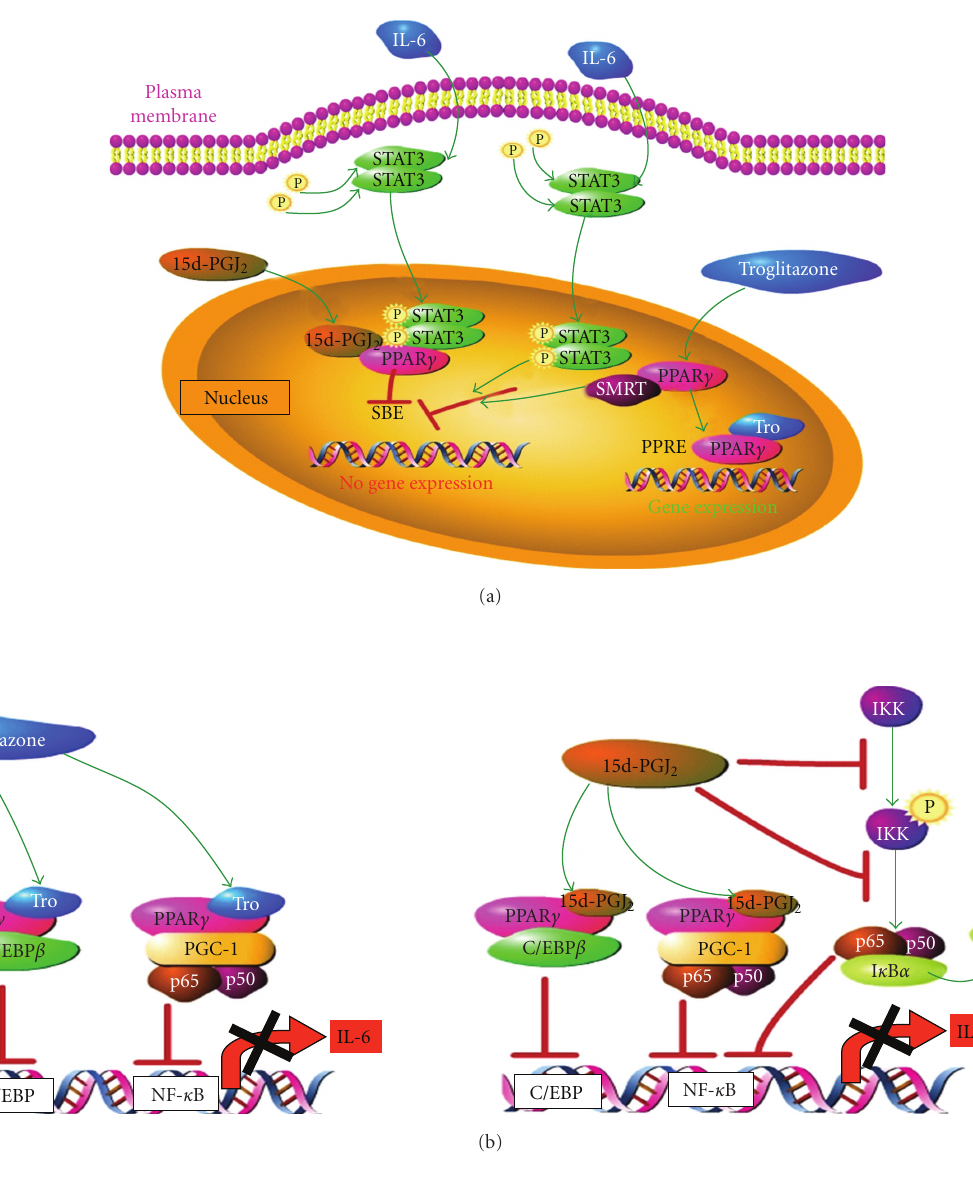
Figure 3: PPAR γ agonists inhibit Stat3-mediated IL-6 gene expression in myeloma cells. Inactivation of IL-6-activated Stat3 by PPAR γ agonists occurs in a PPAR γ -dependent manner; however, the molecular mechanisms by which two distinct PPAR γ agonists (15d-PGJ 2 and troglitazone) suppress IL-6-activated Stat3 in MM cells di ff er as shown in (a) [211]. Direct complex formation between phosphorylated Stat3 and PPAR γ activated by 15d-PGJ 2 prevents Stat3 binding to its cognate response element (SBE) on the promoters of target genes ((a), left). This mode of transcriptional inactivation does not require binding of the activated PPAR γ transcription factor to DNA in the promoter region and, thus, can occur in the absence of a PPRE. However troglitazone activated PPAR γ promotes redistribution of the corepressor SMRT from PPAR γ to phosphorylated Stat3 so that Stat3 can no longer recruit the transcriptional machinery necessary for gene expression ((a), right) [211]. High levels of IL-6 are found in MM and promote myeloma cell proliferation and survival and indirectly promote tumor- associated angiogenesis. The PPAR γ agonists troglitazone and 15d-PGJ 2 have been shown to inhibit transcription of the IL-6 promoter driven by C/EBP β and NF- κ B [212]. Troglitazone-activated PPAR γ binds to C/EBP β preventing binding to its cognate response element on the IL-6 promoter, which is the major mechanistic pathway of troglitazone-mediated downregulation of IL-6 expression. In addition activated PPAR γ competes with NF- κ B for the PGC-1 coactivator, which leads to decreased NF- κ B binding to the κ B response element on the IL-6 promoter contributing to inhibition of IL-6 gene expression, albeit to a lesser extent than inhibition of C/EBP β ((b), left) . A slightly di ff erent mechanistic emphasis on PPAR γ -mediated inhibition of IL-6 gene expression occurs in response to 15d-PGJ 2 . Although 15d-PGJ 2 -activated PPAR γ inhibits C/EBP β -mediated transactivation of the IL-6 promoter similarly to troglitazone-activated PPAR γ , the predominant mode of inhibition is through 15d-PGJ 2 -activated PPAR γ using the coactivator PGC-1 as a bridging protein to interact with NF- κ B to prevent transactivation of the IL-6 promoter. Furthermore, 15d-PGJ 2 inactivates NF- κ B by inhibiting phosphorylation of IKK and I κ B independently of PPAR γ activation ((b), right). The schematics in this figure were adapted from [211,